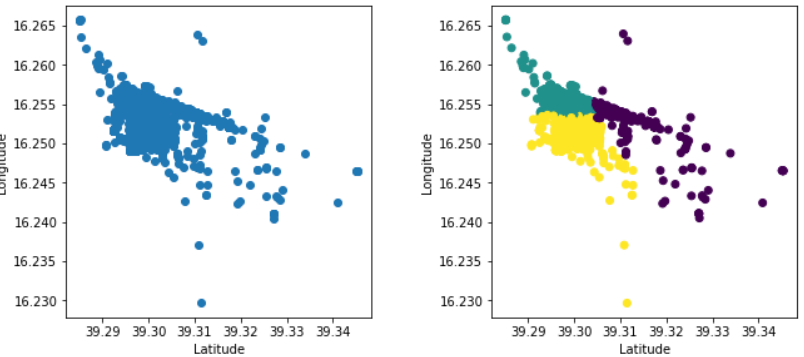
Figure 13. Spectral clustering for all the initial trip positions in the dataset. It should be noted that different trips have been made by the same user and that in some cases the user associated with a specific trip has been clustered in different groups. ( Left ): Latitude vs. longitude plot of all trips without clustering. ( Right ): three clusters of the same position trips, each color refers to a different spectral clustering.